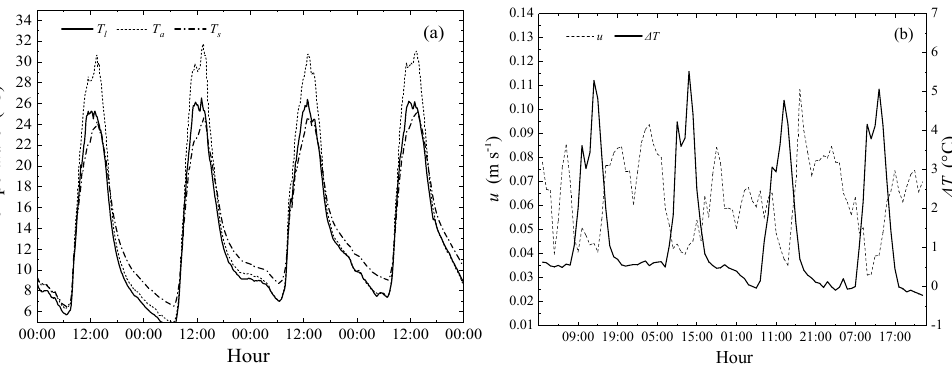
Figure 2. Time course of leaf surface temperature T l , soil surface temperature T s and air temperature T a ( a ); wind speed u, and the temperature difference between T a and T l ( Δ T ) ( b ) from 23 to 26 November 2017.